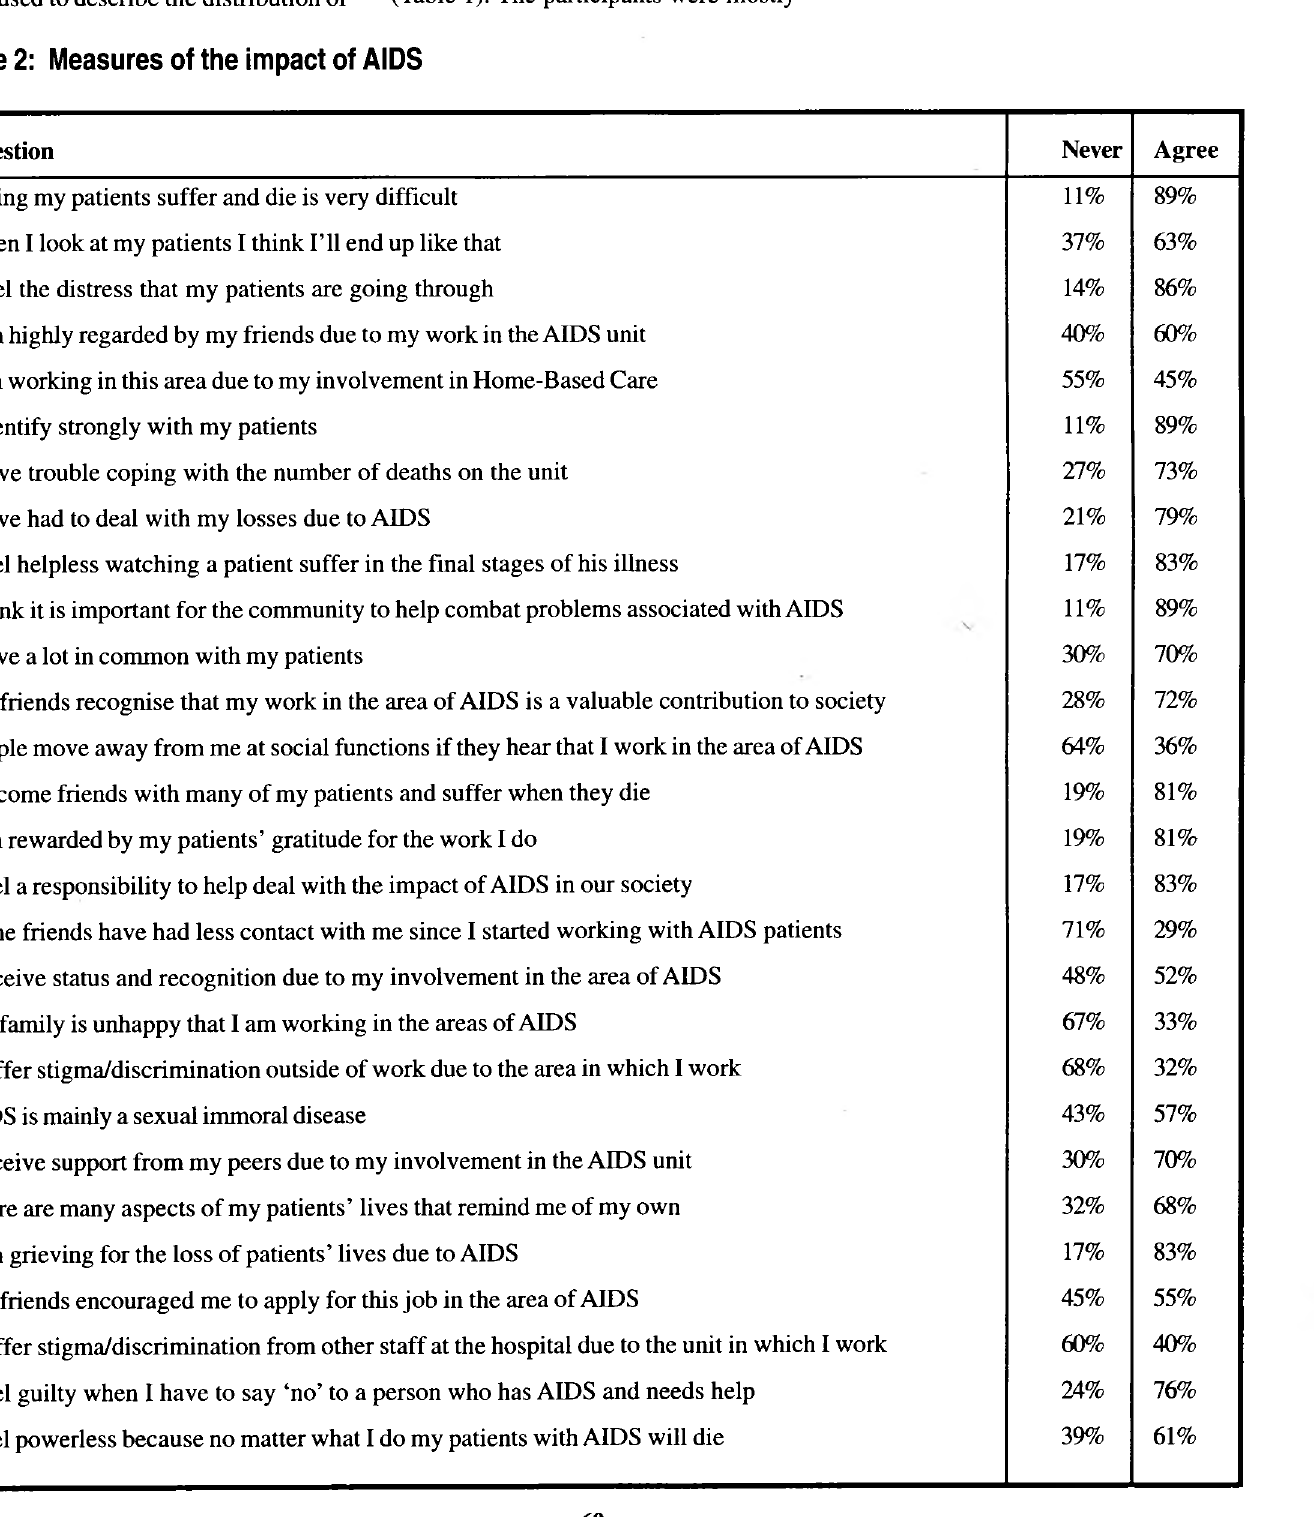
Table 2: Measures of the impact of AIDS